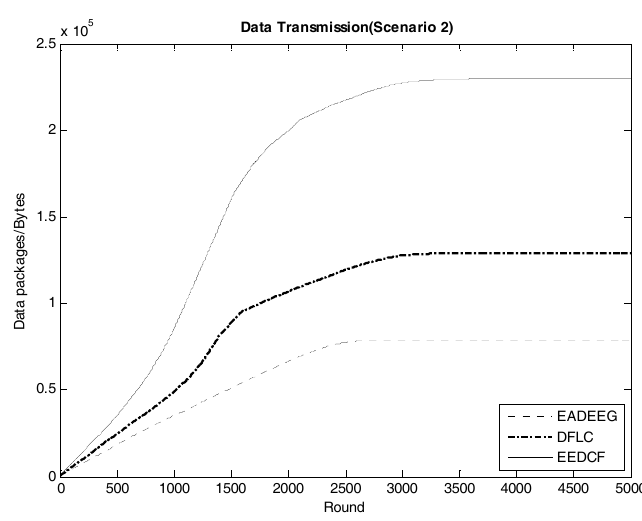
Figure 13. Data transmission in the network of the three algorithms in Scenario 1.